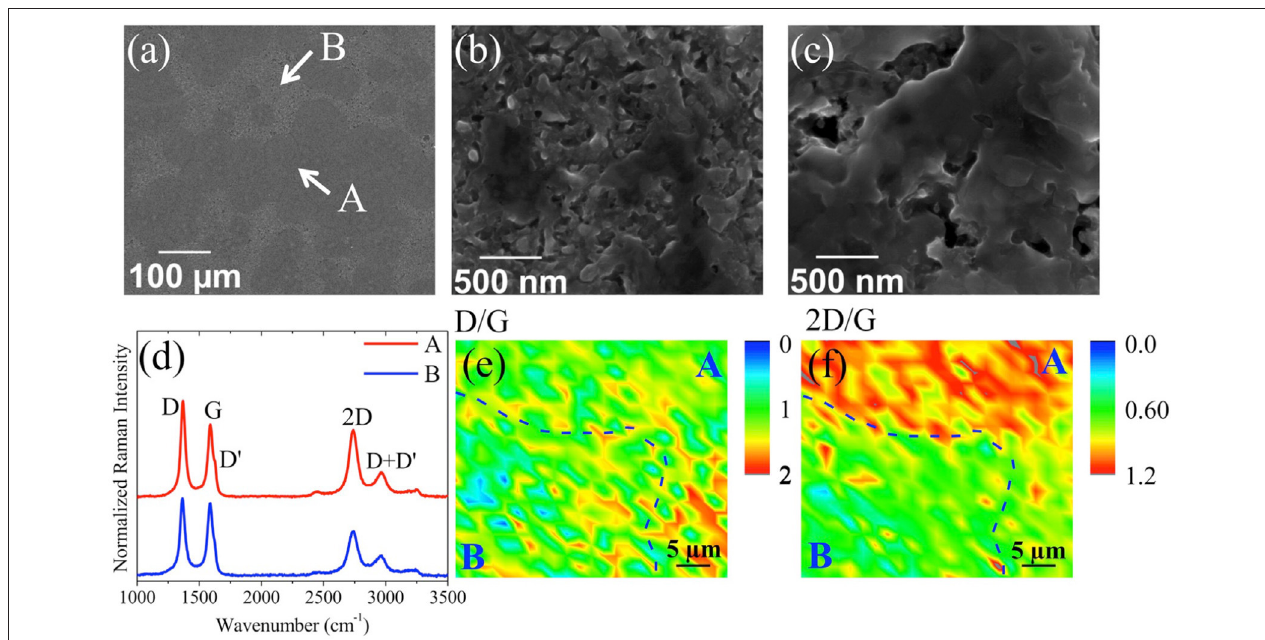
FIGURE 10 | SEM images of a-C (5nm)/Ni/Si after thermal processing at (a) 500 × and 12,000 × magnifications for the areas A (b) and B (c) showing a 3D porous structure; (d) typical Raman spectra at 442nm taken in regions A and B. Raman mapping at 442nm of the intensity ratio on 40 µ m × 40 µ m of (e) D/G and (f) 2D/G, respectively. The dashed lines are guides delimiting regions A and B [Reproduced from Tite et al. (2016) with permission of Elsevier].